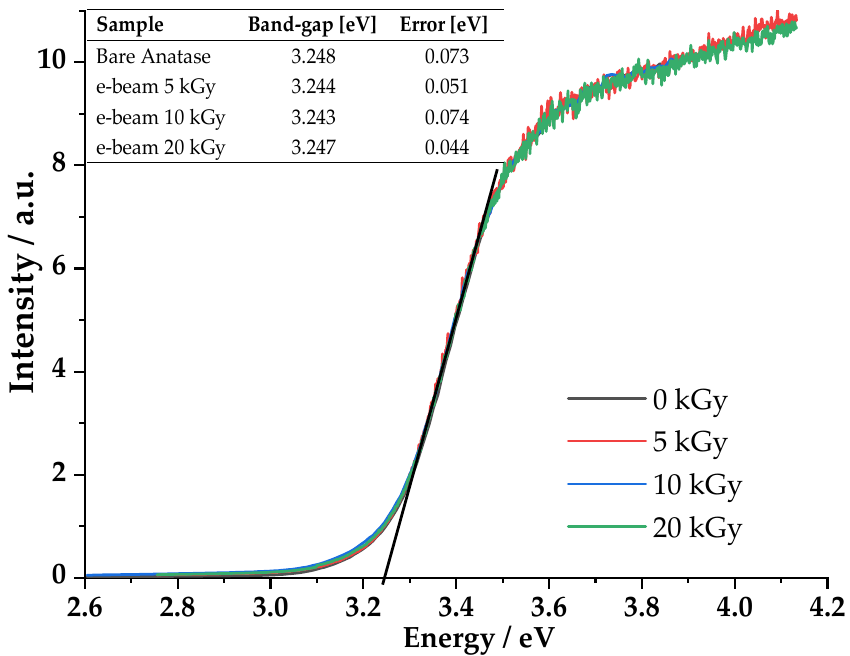
Figure 4. FT-IR spectra of TiO 2 with and without e-beam treatment measured under ambient conditions. Inset, a magnified view of the spectrum of the samples.